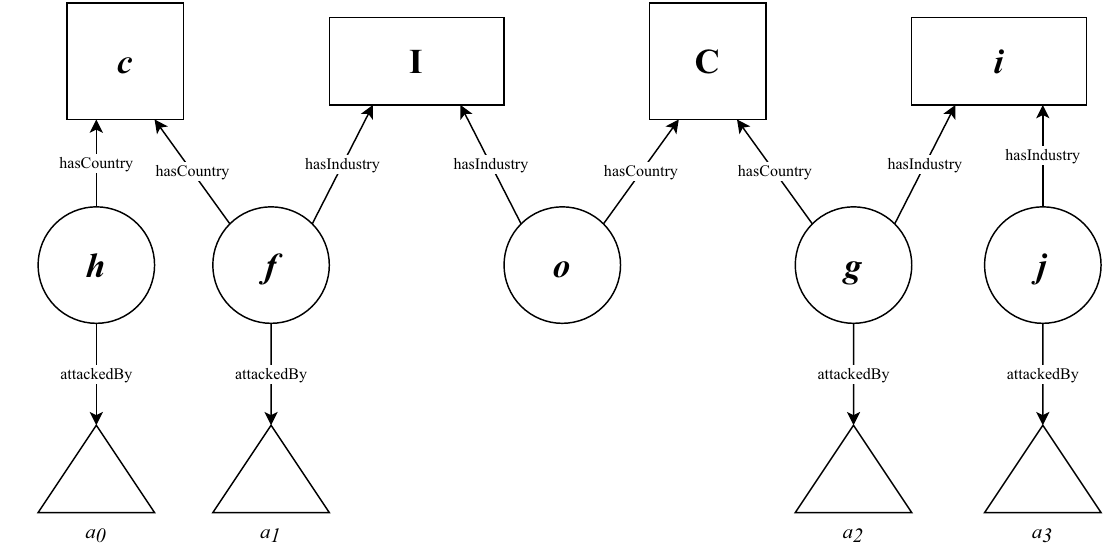
Figure 4. Example of the structure of the knowledge graph for calculating the heuristic risk value for the focal entity o . The focal entity is connected to industry I and country C . The rest of the graph is populated with entities h , f , g and j as well as industry i and country c . The recorded attacks to the entities are denoted from a 0 to a 3 in the order of occurrence at times t 0 to t 3